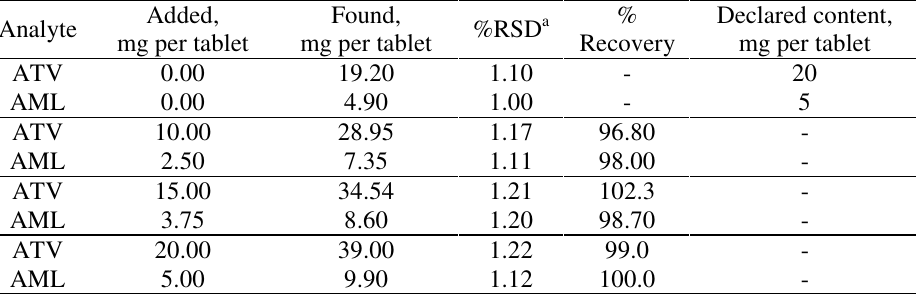
Table 4. Analyses of amostatin tablet from Alhavi